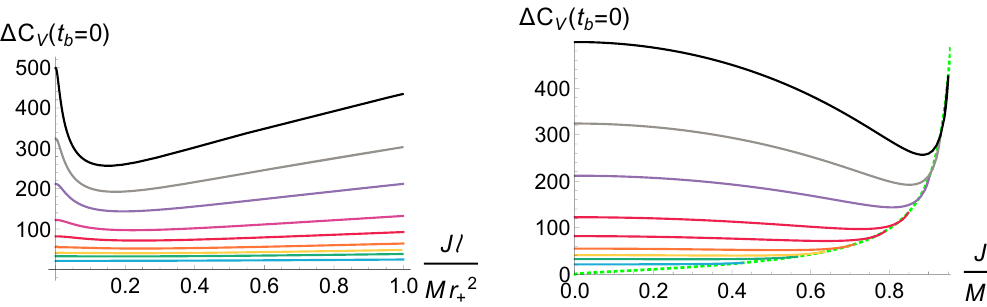
Figure 15 . ∆ C V ( t b = 0) as a function of M and J , for G N = ‘ = 1 . From the bottom up M = 1 , 2 , 3 , 5 , 10 , 20 , 50 , 100 , 200 . As made explicit in the left panel, J spans the full range allowed √ by the condition ‘ Ω + < 1 , or equivalently r + < a‘ , which provides the most stringent bound for any finite M . In the right panel ∆ C V ( t b = 0) is plotted as a function of the dimensionless p combination J/M‘ = a/‘ . Each curve stops at the limiting point r + = J‘/M , corresponding to the superimposed green dotted curve. ∆ C V ( t b = 0) remains finite, but as J/M‘ approaches 1 it rapidly increases as a function of M